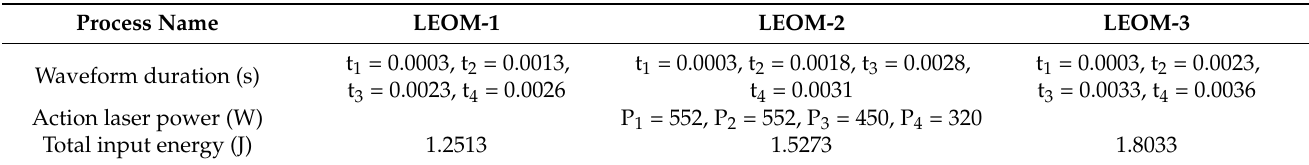
Table 3. Optimized process parameters of LSMW on the ANSI 304 stainless steel sheet.